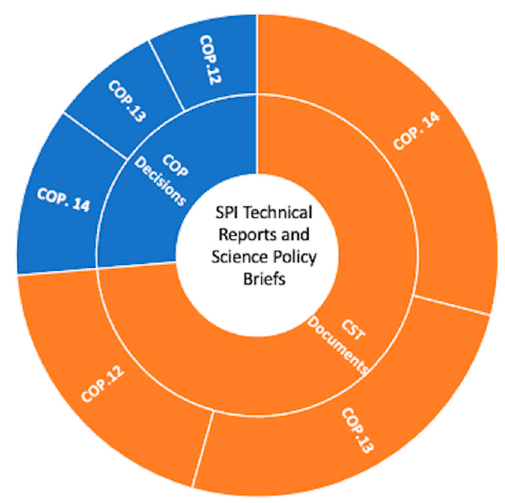
Figure 2. Scientific input from the SPI into COP decisions. Proportion of SPI technical reports and science policy briefs that were incorporated into CST documents and COP decisions over three COPs from 2012 to 2019.